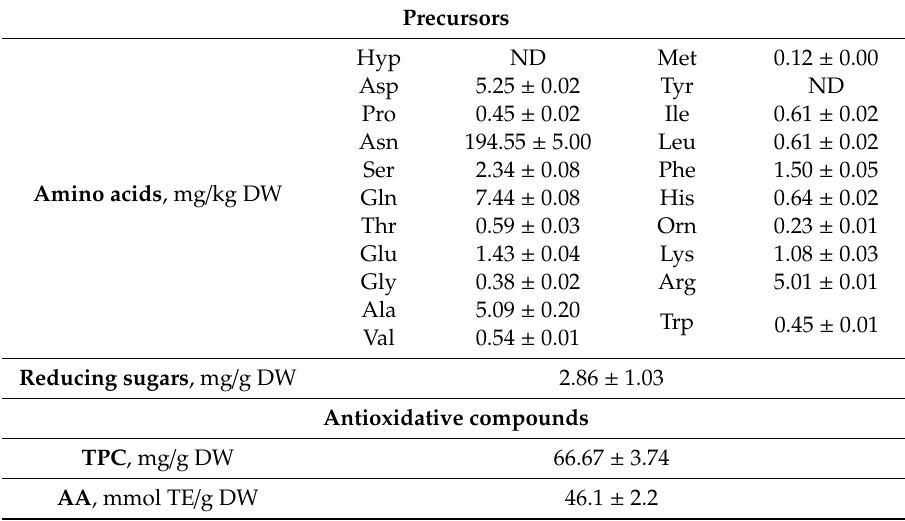
Table 1. The precursor levels and antioxidative compounds in sea buckthorn